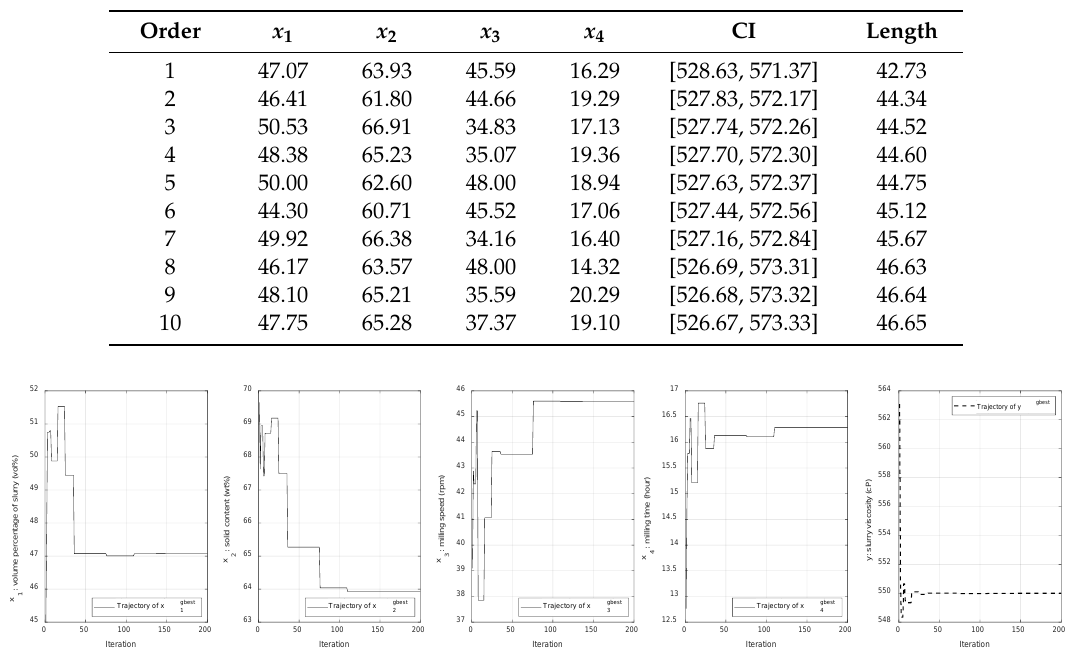
Figure 10. Trajectories of x gbest and ˆ y ( x gbest ) during the search for the x ∗ using the PSO algorithm: (1) ( a ) trajectory of x gbest ; ( b ) trajectory of x gbest ; ( c ) trajectory of x gbest ; ( d ) trajectory of x gbest ; ( e ) trajectory 2 3 1 4 of ˆ y ( x gbest ) .